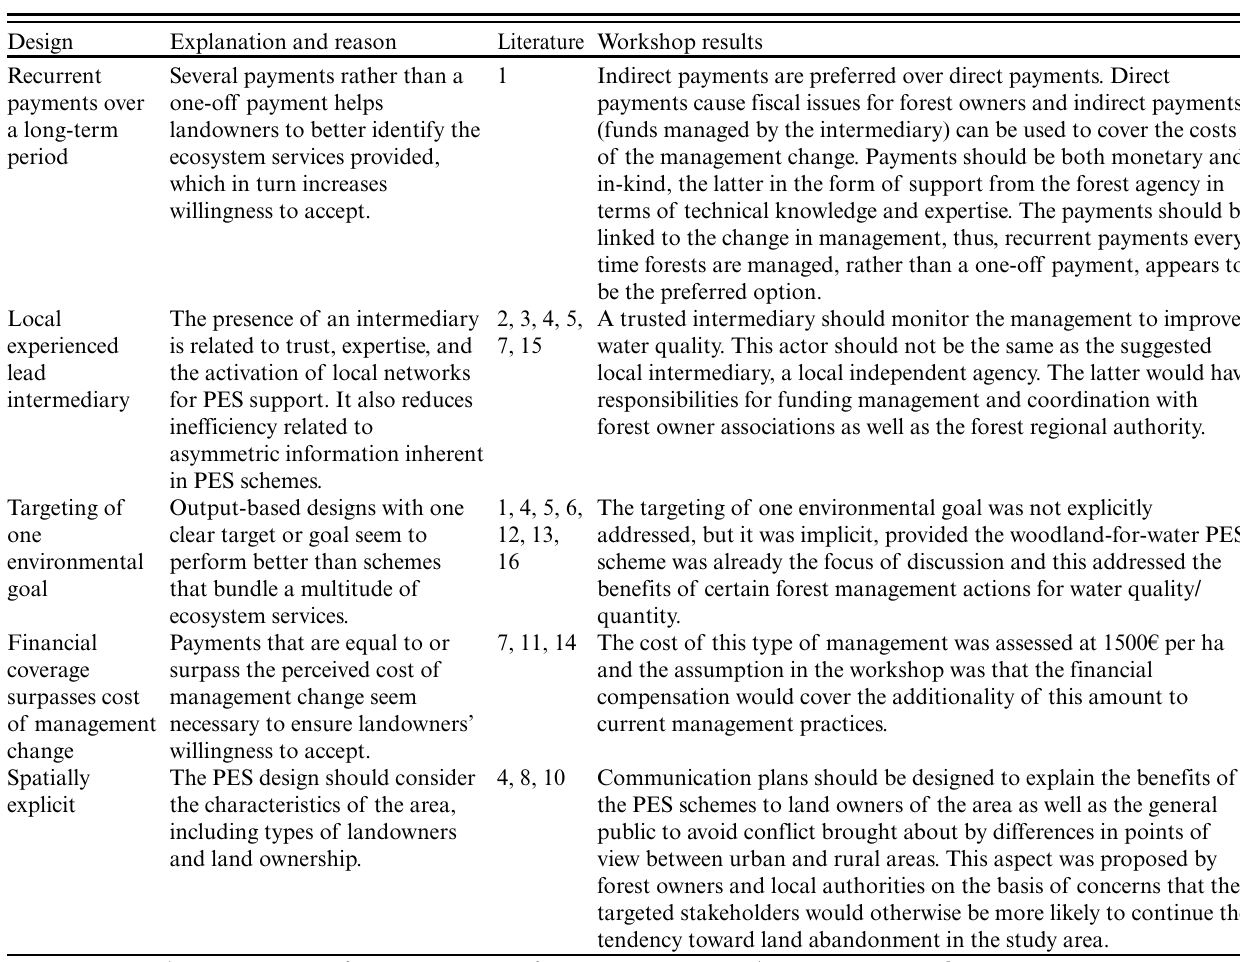
Table 1 . Optimal design characteristics in payments for ecosystem services (PES) schemes, as discussed in the literature and workshop